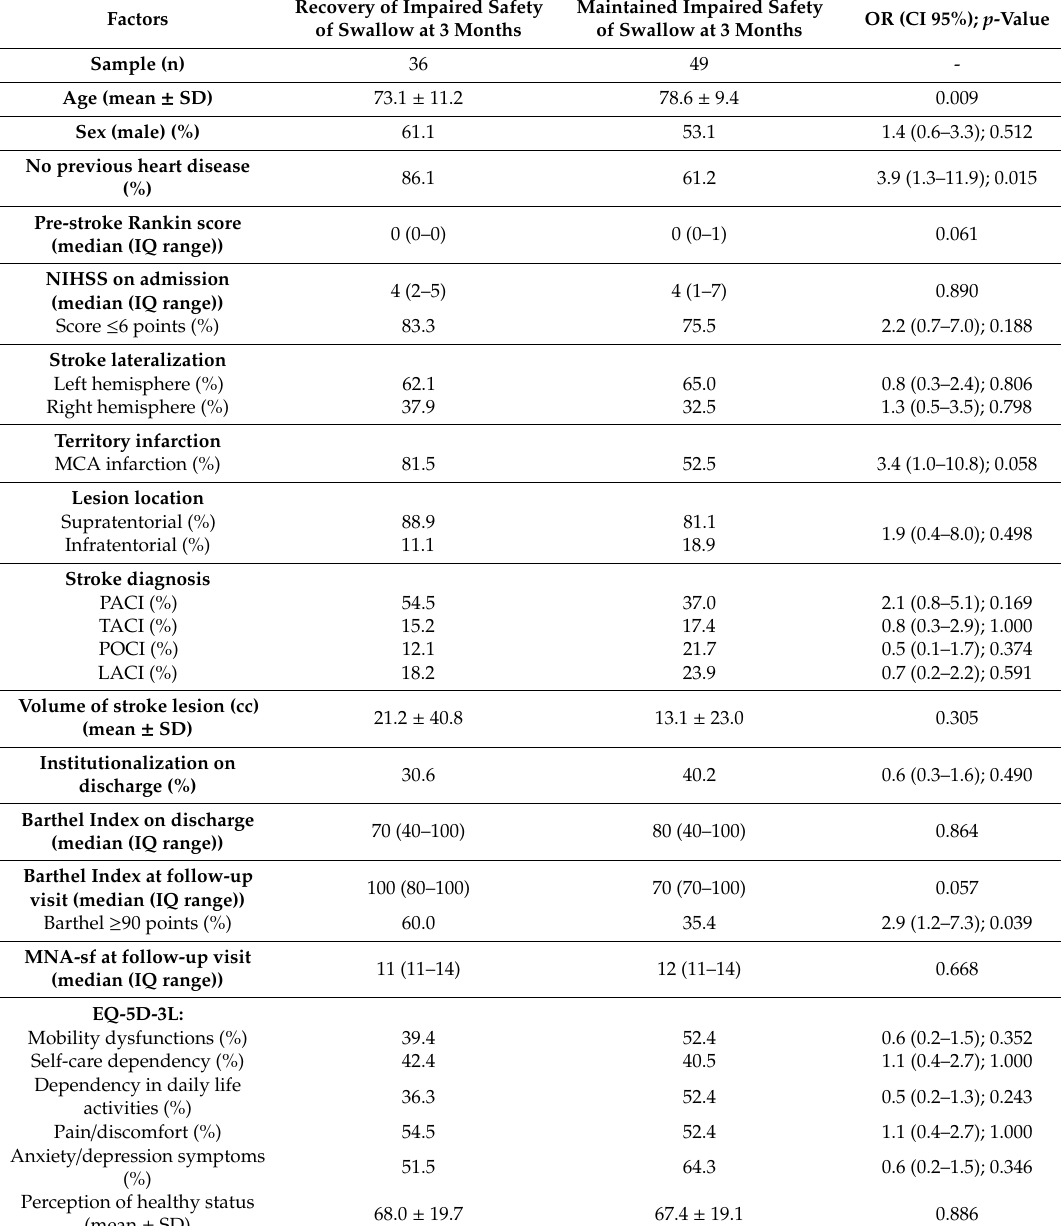
Table 2. Factors associated with recovered safety of